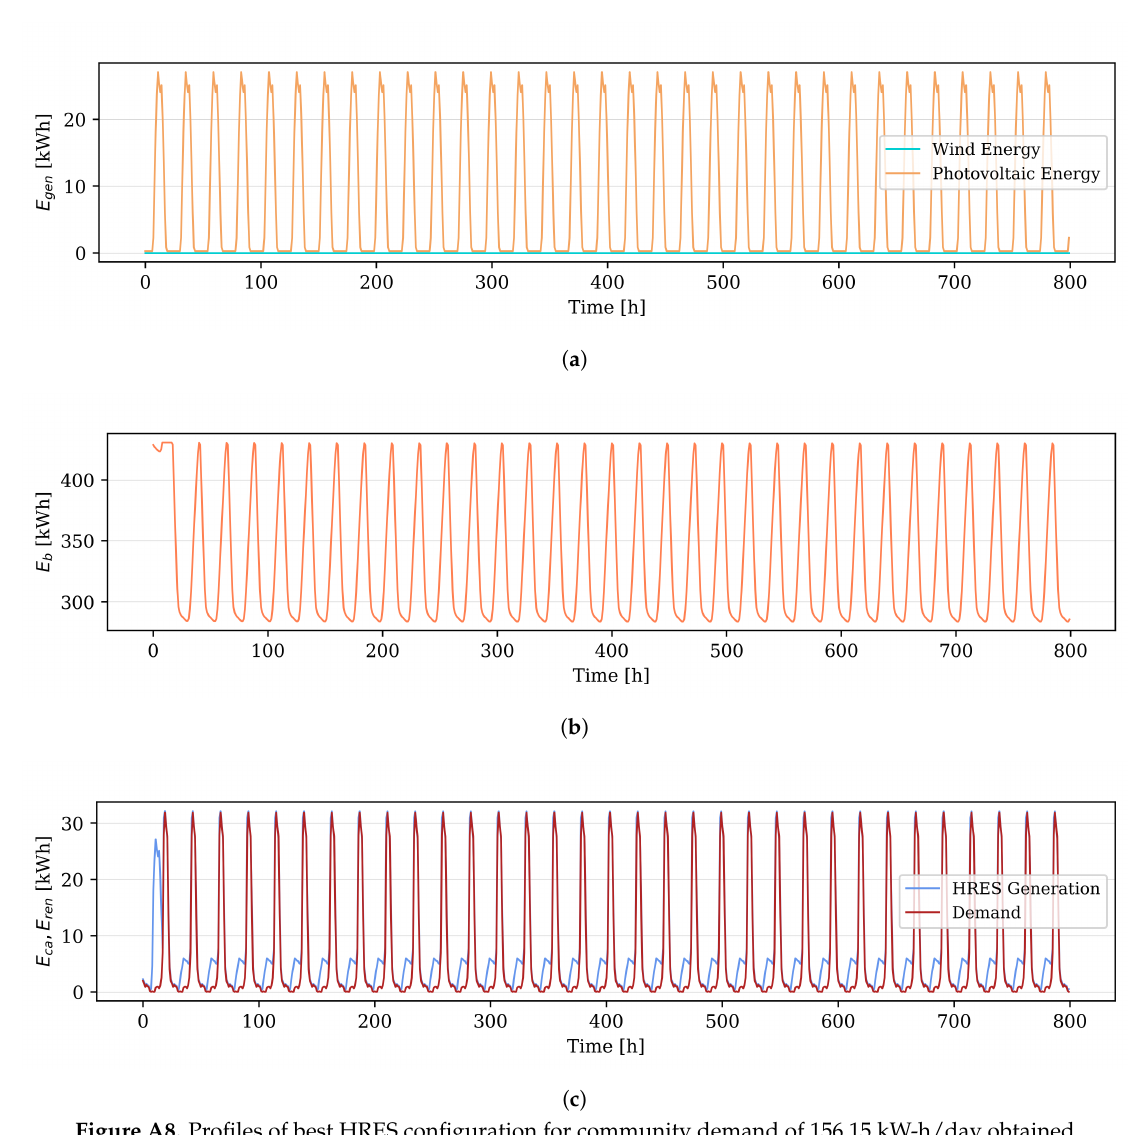
Figure A8. Profiles of best HRES configuration for community demand of 156.15 kW-h/day obtained by multi-objective function with TAC , N pv ,1 = 341, N pv ,2 = 2, N pv ,3 = 2, N b = 319. ( a ) Total renewable energy generation. ( b ) Storage system state. ( c ) HRES generation vs.